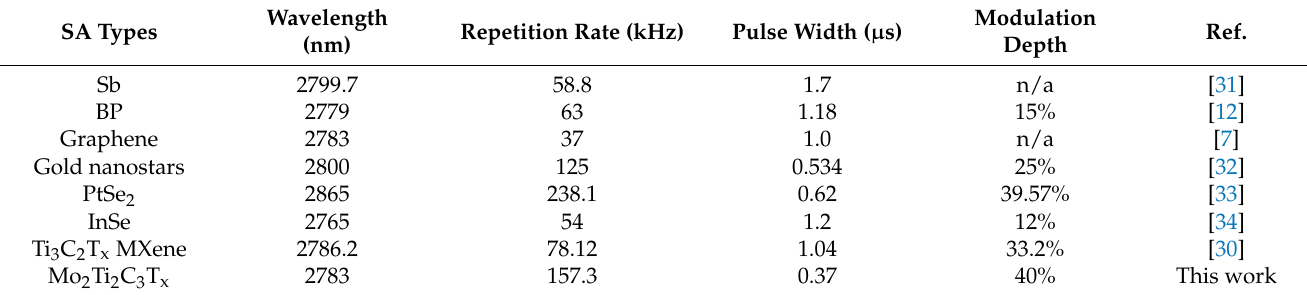
Table 1. Comparison of several reported passive Q-switched erbium-doped fluoride fiber lasers based on nanomaterial saturable